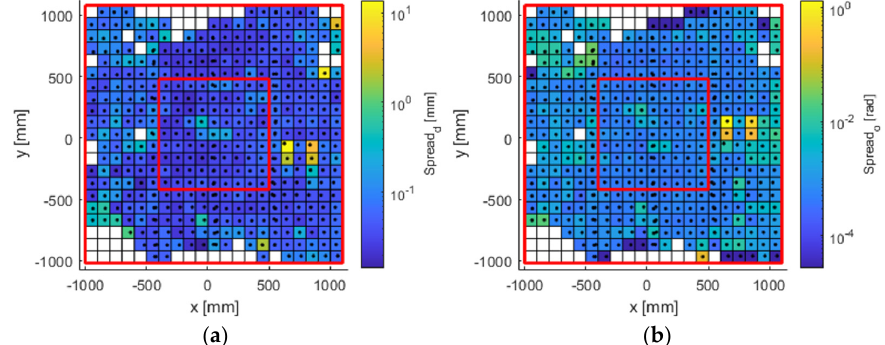
Figure 10. Error spread in ( a ) position (mm); and ( b ) orientation (rad). The available work area. The red lines delimit the large and inner areas.